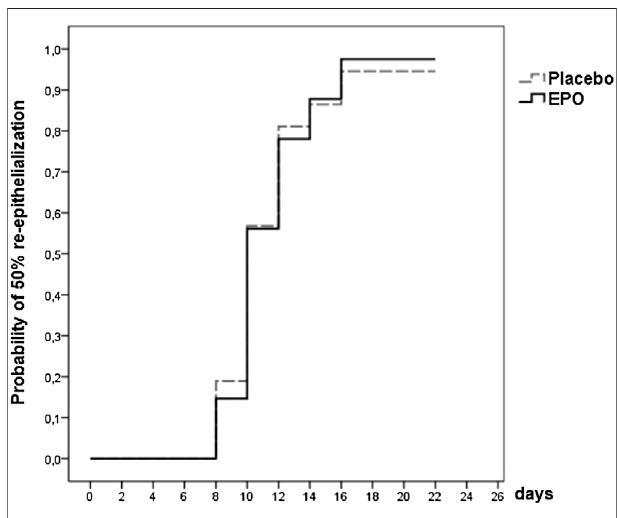
FIGURE 1 | Survival function showing the likelihood of 50% re- epithelialization through day 21 for thepatientsof the twotreatmentarms with documentation of the study wound [data were censored for three patients (4%)].